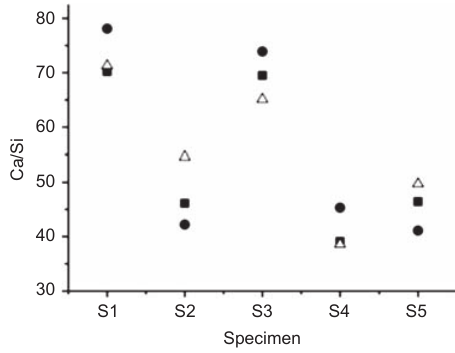
Figure 10 Ca/Si ratio at the interface after